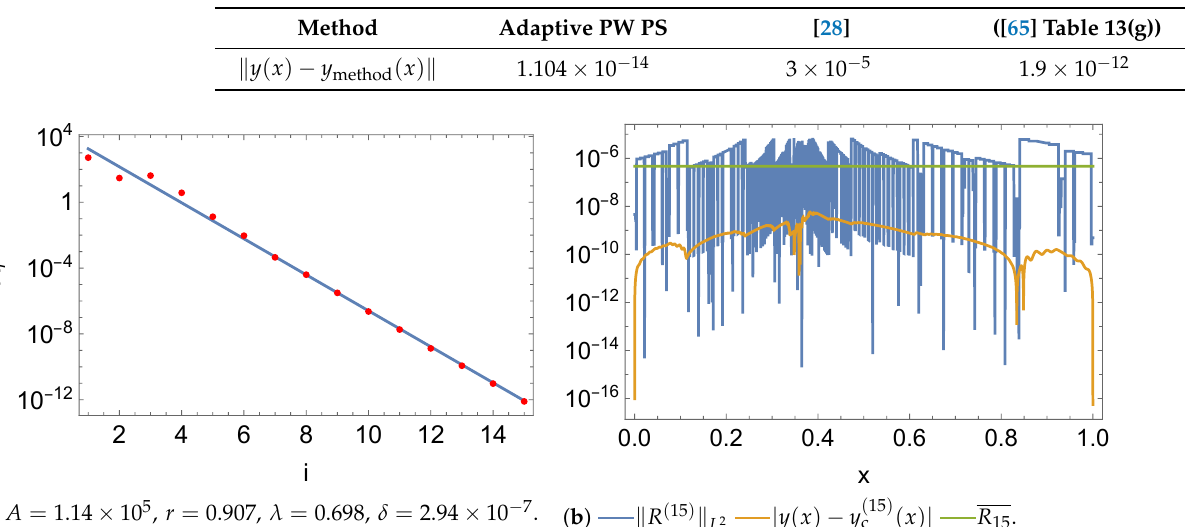
Table 1. Comparison of the L 2 norm of the approximation error for different methods.